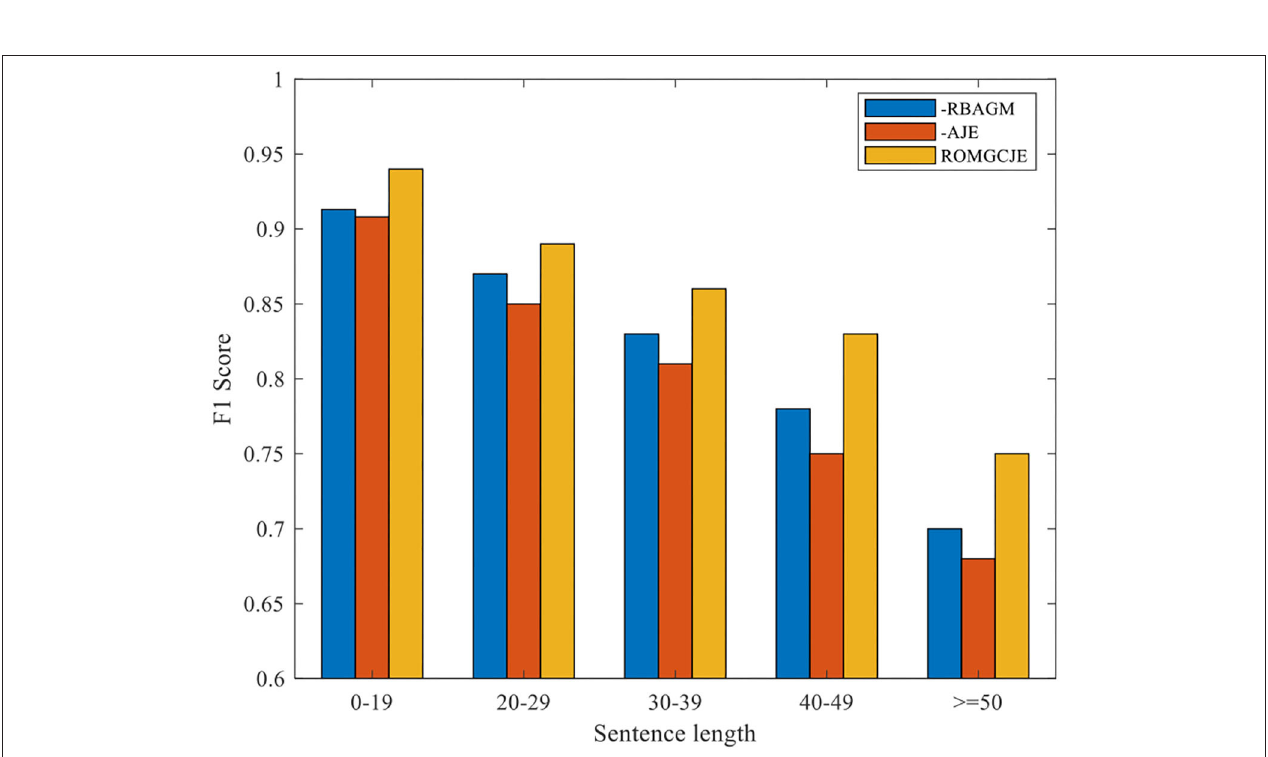
FIGURE 7 | Comparison of the ROMGCJE, “–RBAGM,” and “–AJE” under different sentence lengths on the NYT dataset.